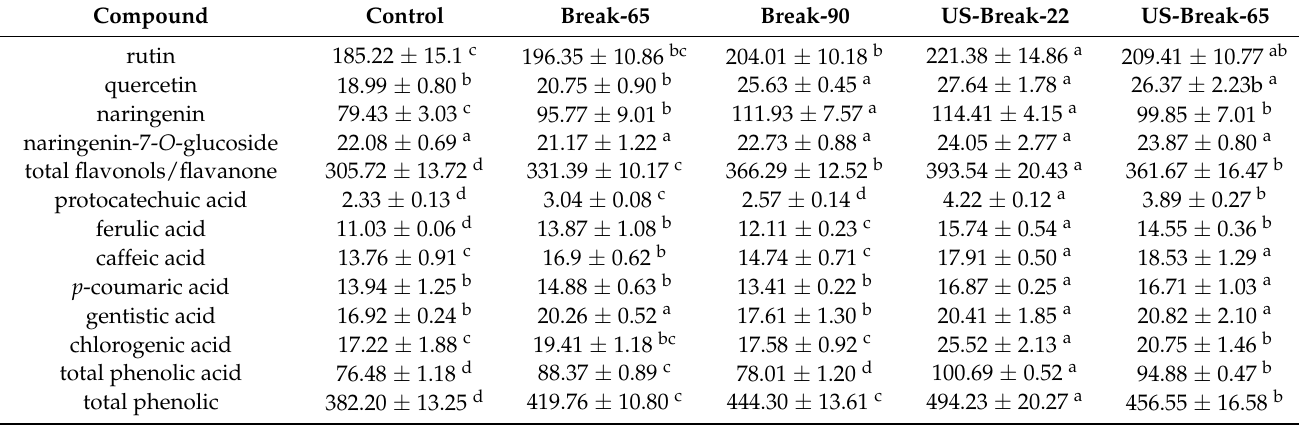
Table 2. Effects of different breaking treatments on the phenolic content ( µ g/g DW) of the tomato pastes. Compound